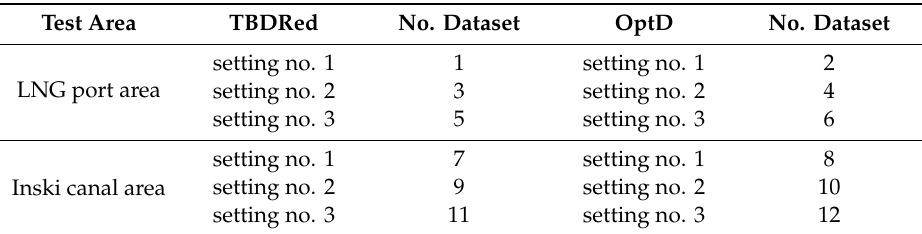
Table 1. Settings used and possible resulting sets.